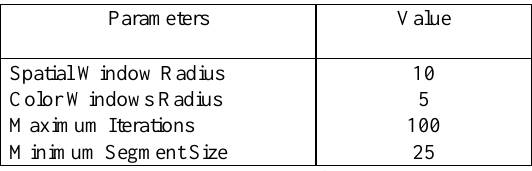
Table 3. Used Mean-Shift parameters